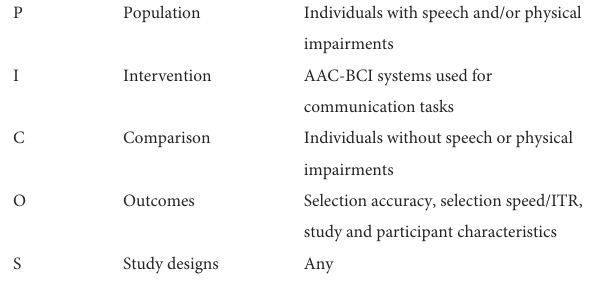
TABLE 1 PICOS criteria for the systematic